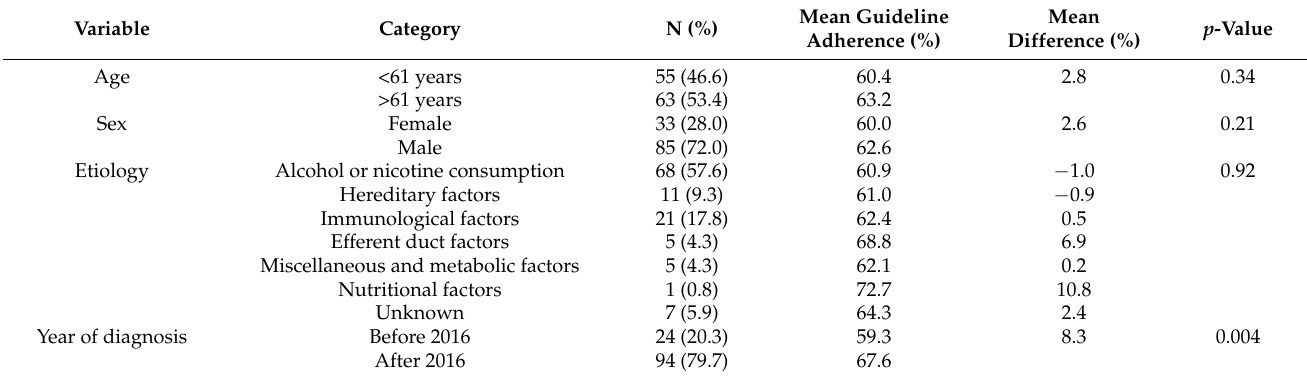
Table 3. Differences in total quality indicator mean adherence rate between cohort subgroups. Percentage in mean difference in case of etiology was calculated as the difference, and each was compared with the overall mean value.